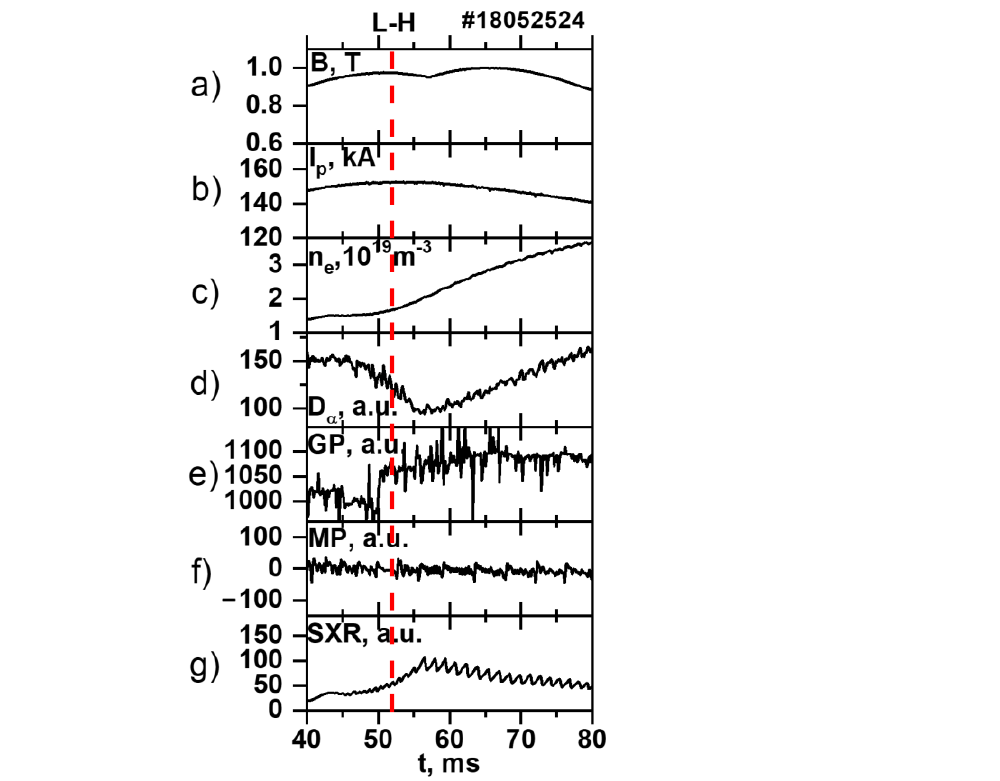
Figure 1. Plasma parameters during a TUMAN-3M discharge with a transition to H-mode: ( a ) toroidal magnetic field B τ , ( b ) plasma current I p , ( c ) electron density n e , ( d ) D α signal, ( e ) gas puff (puffing rate increased to achieve L–H transition), ( f ) magnetic probe signal, ( g ) soft X-ray (SXR) signal. Red, dashed line at 52 ms indicates the L–H transition.